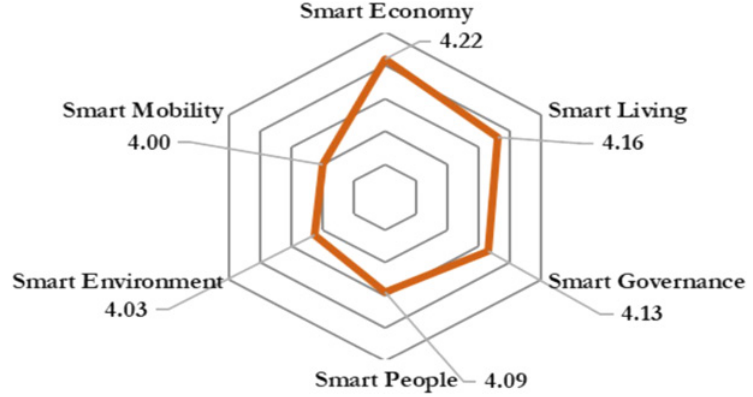
Role of Smart City Drivers in the Resilient City Formation